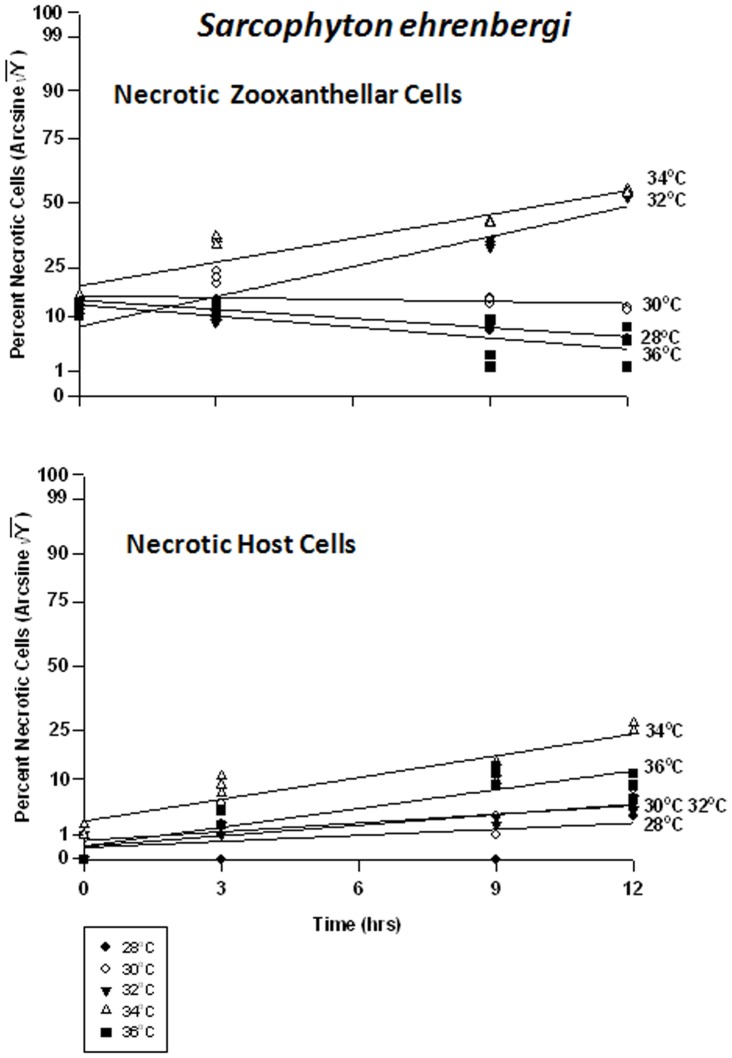
Effects of seawater temperature on percent necrotic endosymbiotic Symbiodinium and host coral Sarcophyton ehrenbergi cells.In-hospite, collected over a12 h period. Corals exposed to 28 to 36°C treatments. • = 28°C; ○ = 30°C;▾ = 32°C; Δ = 34°C; ▪ = 36°C. Data transformed by arcsine for normalization purposes. Zooxanthellae: No significant linear regression at 28°C, 30°C, and 36°C. Significant positive linear regression at 32°C (p<0.05; Y = 2.218X +20.396). Significant non-linear positive response at 34°C (p<0.001); linear trend shown to facilitate comparison (Y = 1.760X +29.396). Host Cells: No significant linear regression at 28°C or 30°C (p>0.05); i.e., the regression coefficient is not significantly different from “0”. Significant positive linear regression at 32°C and 34°C (p<0.05; Y = 0.826X +3.017, and Y = 1.701X +8.922, respectively). Positive non-linear response at 36°C (p<0.01); linear trend shown to facilitate comparison (Y = 1.470X +3.080).